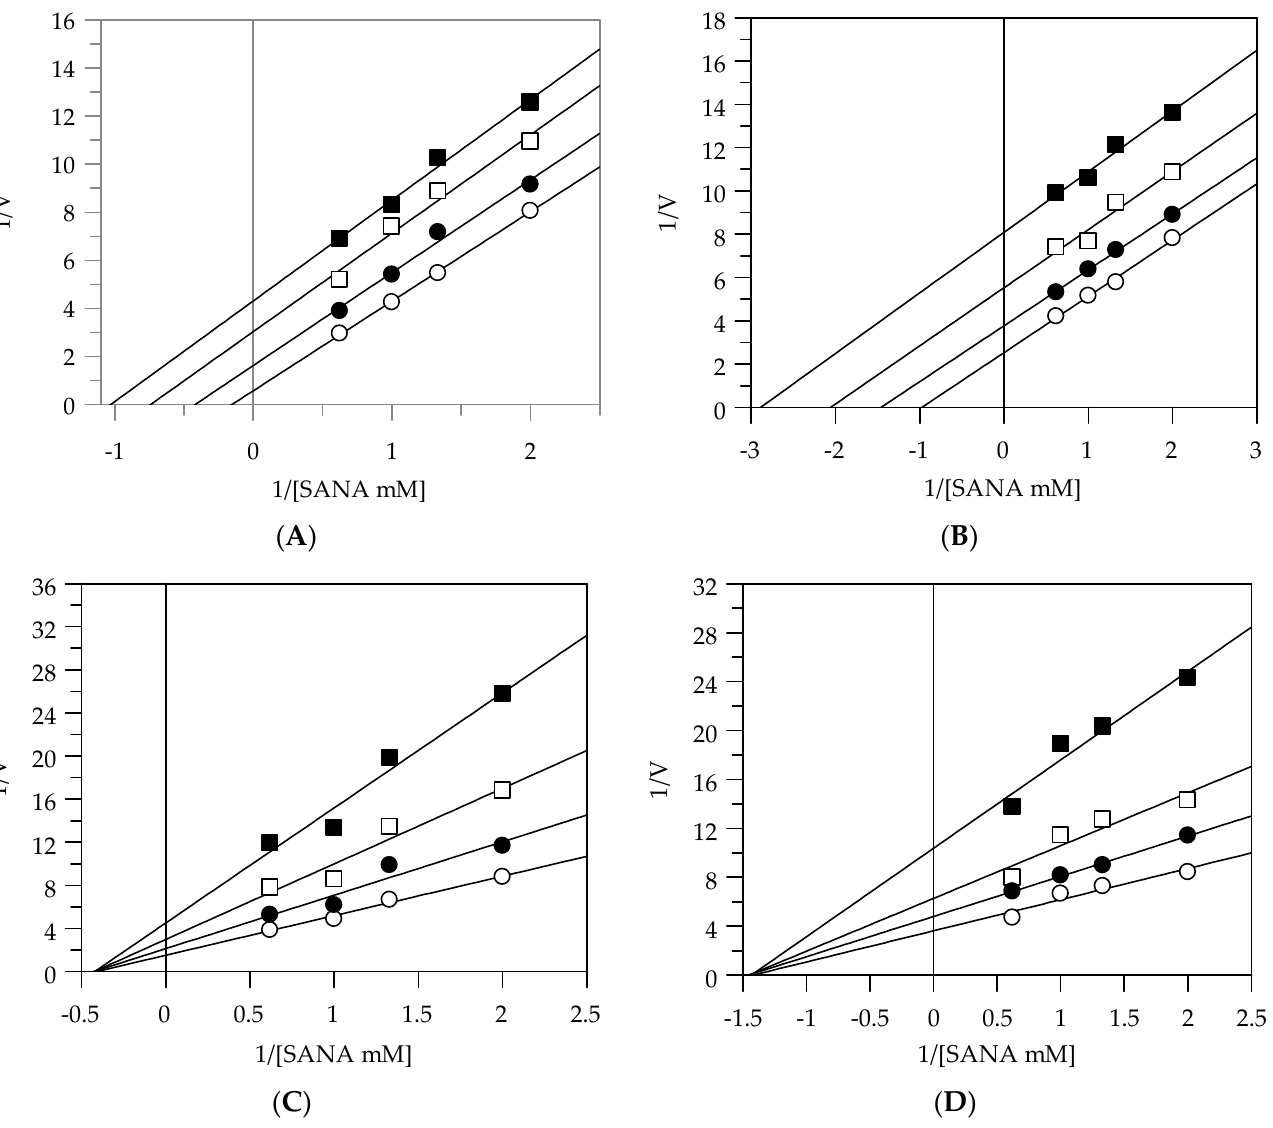
Figure 2. Inhibition of elastase activity, using N-succ-(Ala)3-nitroanilide (SANA) as a substrate. Lineweaver–Burk plots analysis of EEG ( A ), EES ( B ), MEG ( C ), and MES ( D ). Reaction conditions are reported in Section 3. The different concentrations of all the extracts were 0 ( ○ ), 5 ( ● ), 10 ( □ ), and 20 ( ■ ) µg/mL.